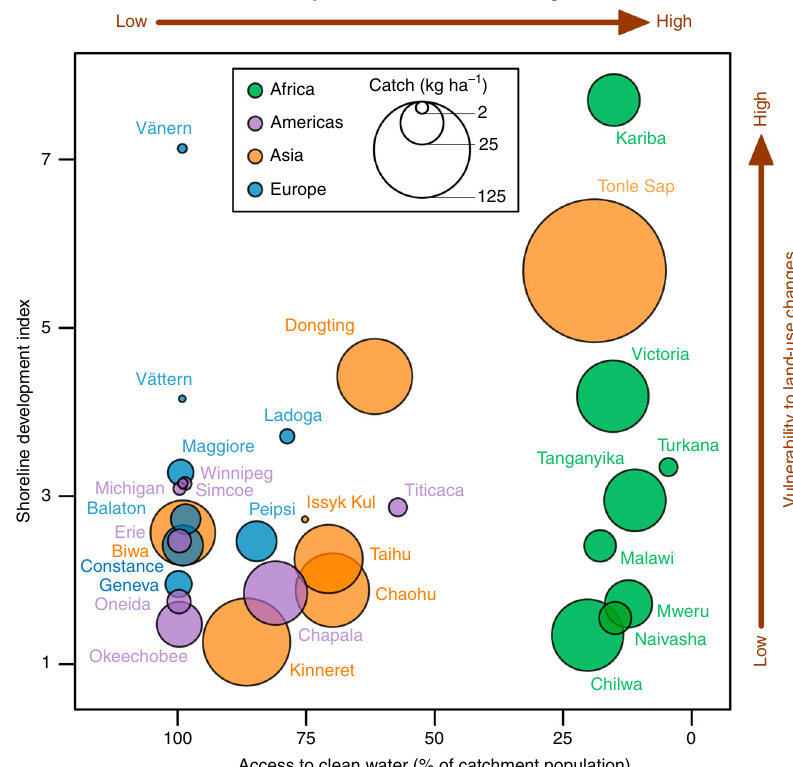
Fig. 8 Distribution of the 31 study lakes with respect to access to clean water and shoreline development index. The area of each circle is proportional to the median fi sh catch in the period 1970 – 2014. Based on the correlation analysis shown in Fig. 7, lakes located in areas with lower access to clean water are more vulnerable to substantial decreases in fi sh catches driven by either climate or land-use change and lakes with larger shoreline development index are more vulnerable to substantial decreases in fi sh catches driven by land-use change. Source data for this fi gure are provided as a Source Data fi